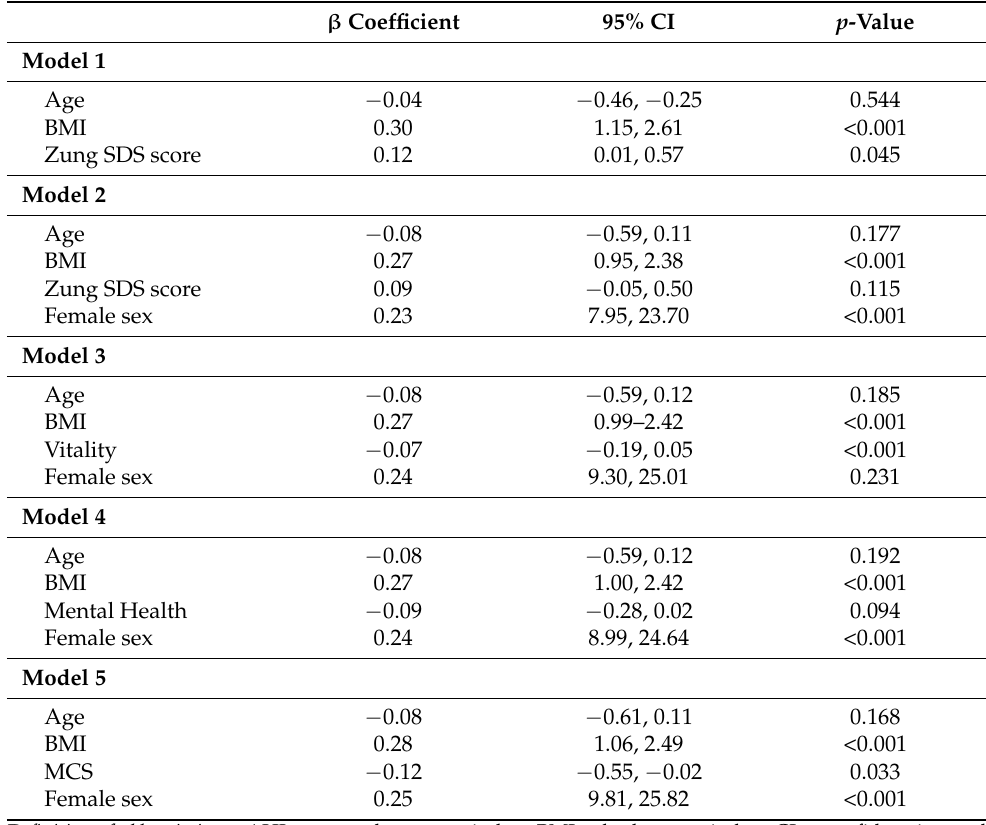
Table 5. Variables associated with REM-AHI in adjusted linear regression